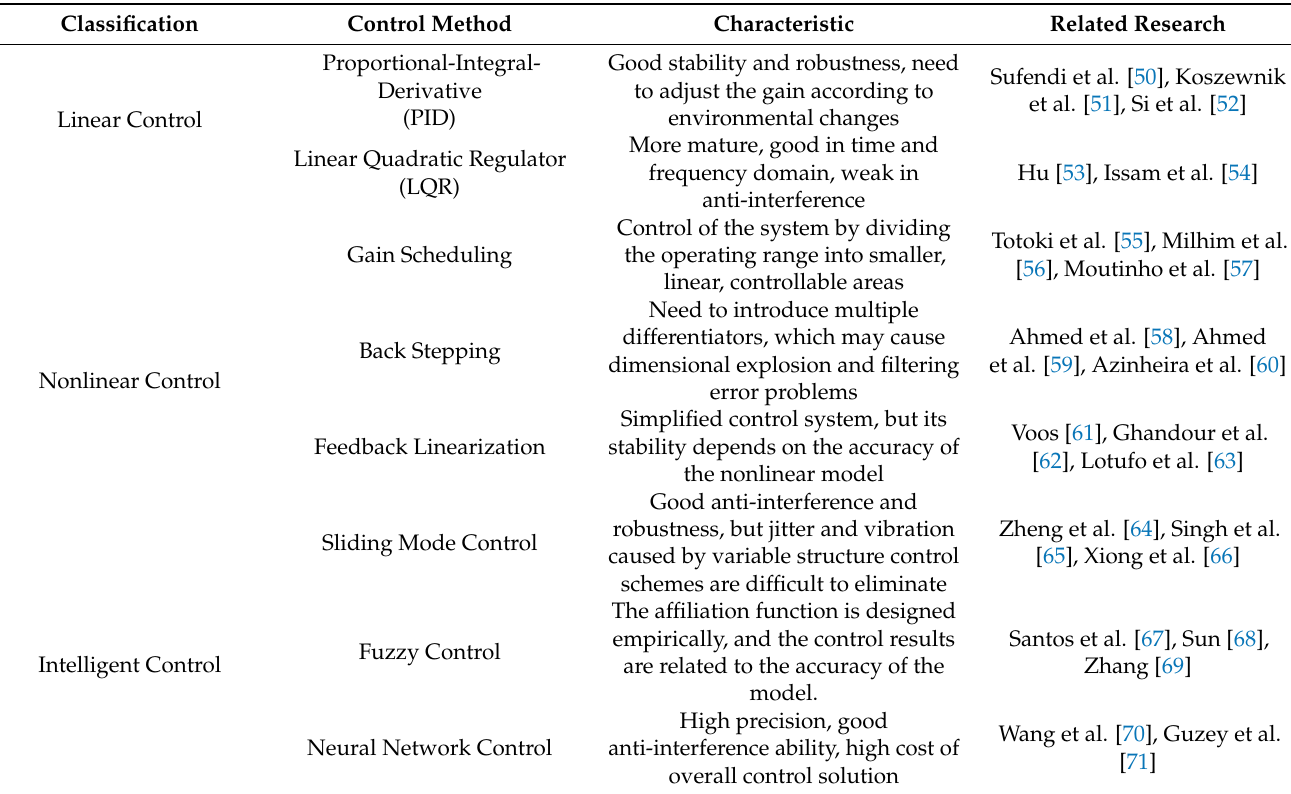
Table 2. UAV control